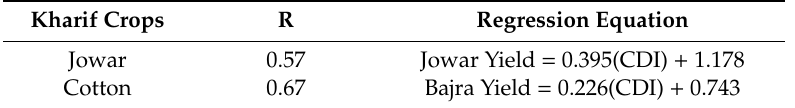
Table 7. Correlation and regression between CDI values and crop yield anomalies for the Kharif